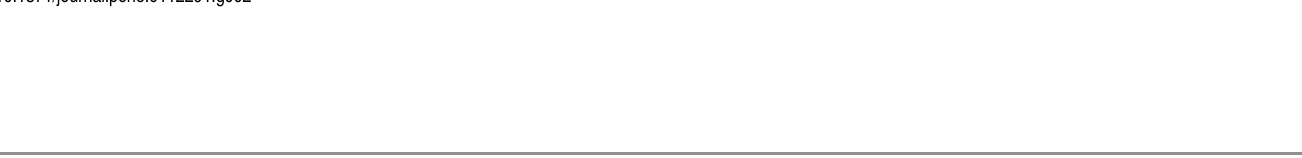
Figure 2. Expression profiles of sorted p75 high cells. A) The expression of marker genes in sorted p75 high and p75 low cells. The mRNA expression of each gene was analyzed by RT-qPCR in undifferentiated 201B7 (hiPSCs) and sorted p75 low and p75 high cells, and was shown as a relative value using the level in sorted p75 high cells as 1.0. Average ¡ SD. N 5 3, biological triplicates. B) Clustering analyses of NCC markers in p75 high populations from several hESC and hiPSC lines. Marker genes for each sub-population of NCCs were labeled using the indicated colors.